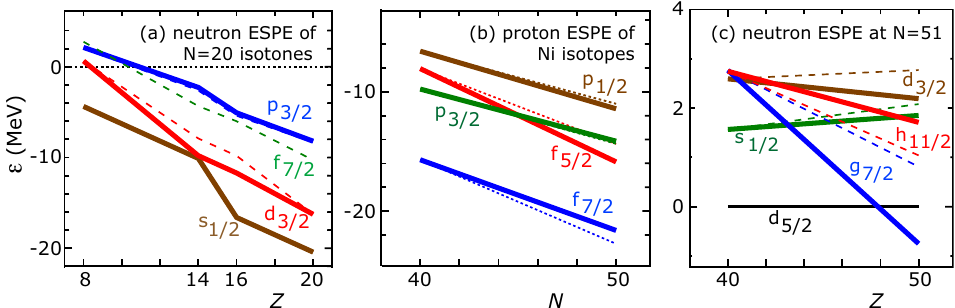
Figure 6. ESPEs calculated by the V MU interaction. The dashed lines are obtained by the central force only, while the solid lines include both the central-force and the tensor-force contributions. See text for more details. Taken from